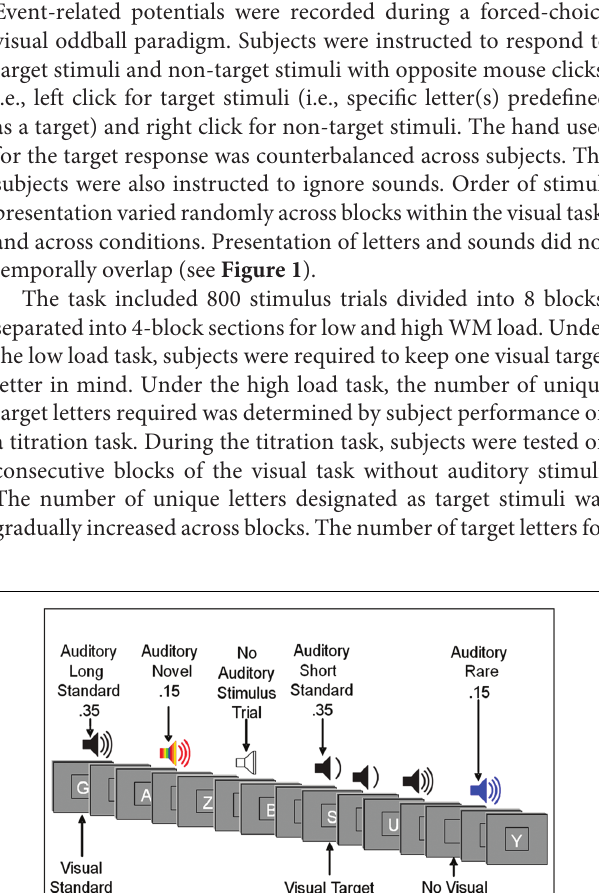
Frontiers in Human Neuroscience |